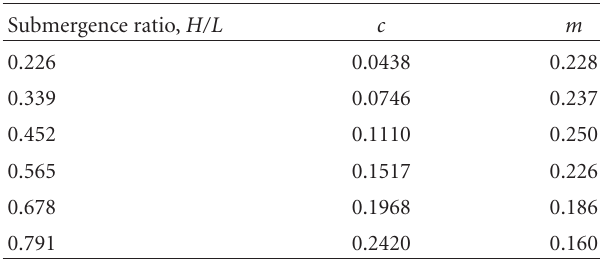
Table 1: Least-squares estimates for the coe ffi cients in